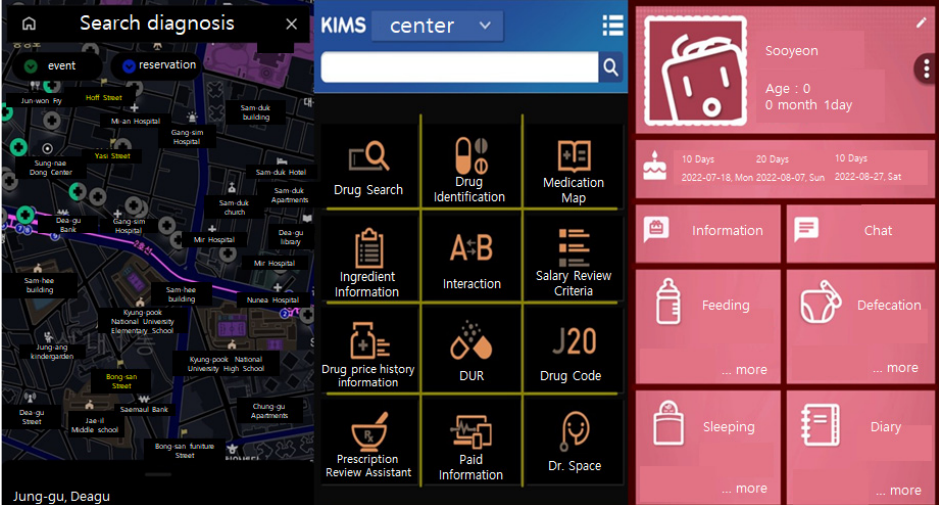
Figure 1. Sample of VCDA test app screenshot .